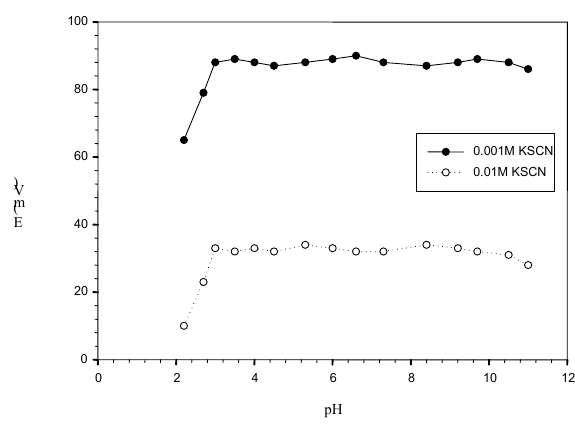
Figure 1. Effect of pH on response of iodide selective electrode at 1×10 -3 M iodide and 1×10 -2 M iodide. Membrane compositions and measurement conditions are given in Table